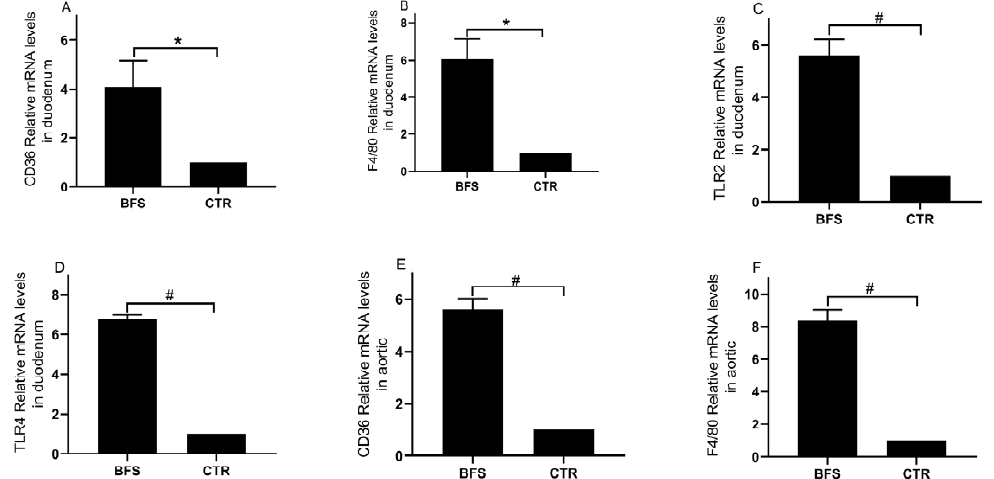
Figure 2. The mRNA expressions of CD36, F4/80, TLR2, and TLR4 in the duodenum and aortic tissue of mice; ( A – D ), CD36, F4/80, TLR2, and TLR4 mRNA expression levels in duodenum tissue, respectively; ( E , F ), CD36 and F4/80 mRNA expression levels in aortic tissue, respectively. * p < 0.05, # p < 0.01 compared with the CTR